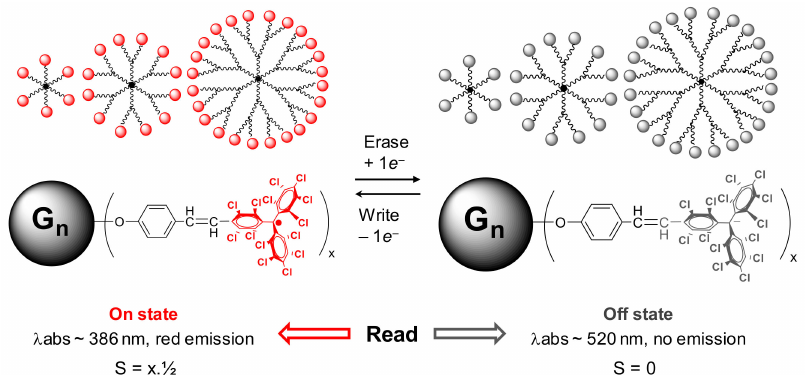
Figure 5. Representation of the electrochemical bistability of PTM radical dendrimers (PPH Gn(PTM • ) x , n = 0–2, x = 6–24). The PTM molecule has two redox states, the radical (left) and anion (right) forms, which can be electrochemically interconverted. Each state exhibits different magnetic and optical properties: radical dendrimers Gn(PTM • ) x exhibit spin S = x · 1 / 2 , an absorbance band at 386 nm, and red fluorescence emission, and anion Gn(PTM − ) x is a diamagnetic species with S = 0, a maximum absorbance band at ca. 520 nm, and is not fluorescent. Published by Chem. Mater. In 2019